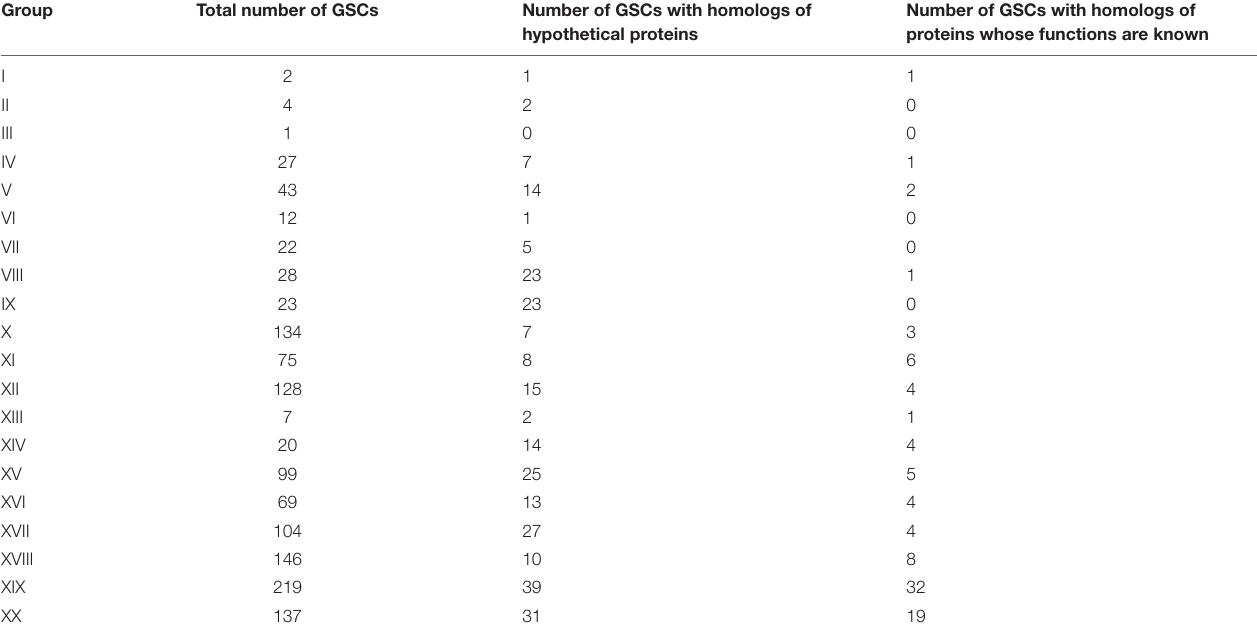
TABLE 1 | The number of group-specific clusters. Group Total number of GSCs Number of GSCs with homologs of